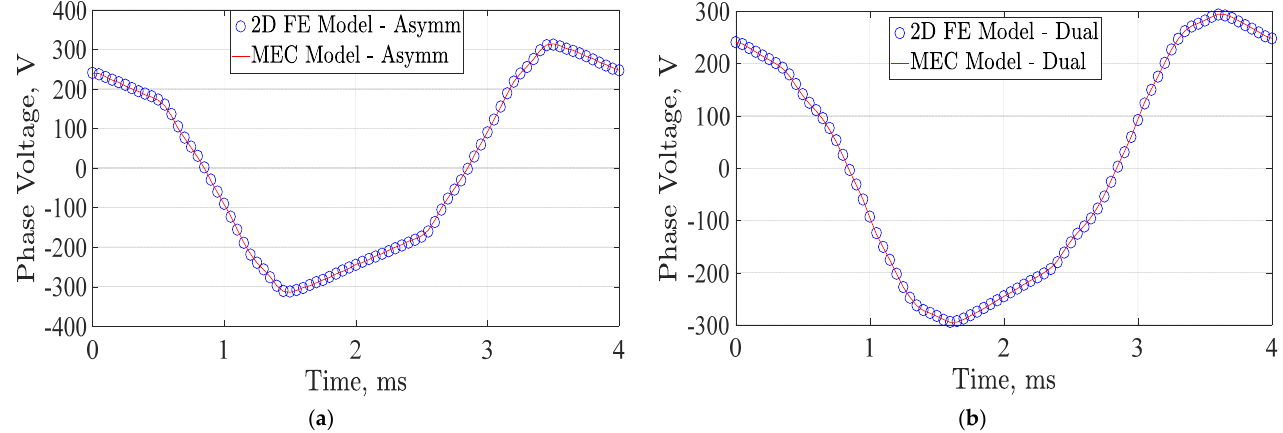
Figure 14. Phase voltage profiles under propulsion mode. ( a ) Asymmetrical winding layout and ( b ) dual three-phase winding layout.